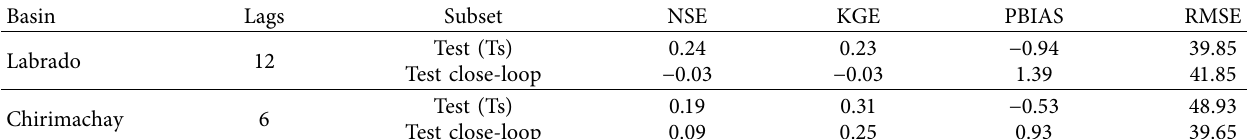
Table 4: Results for SVM models.